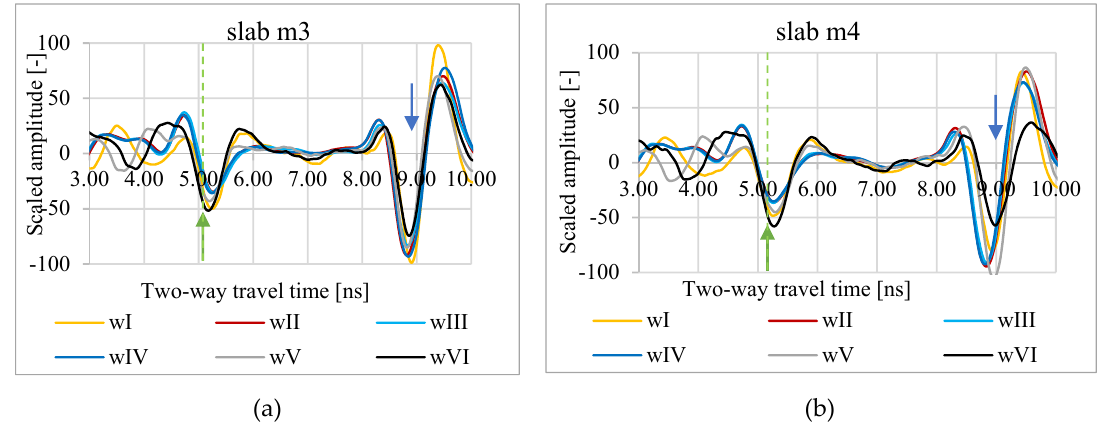
Figure 3. A-scans of m1 ( a ) and m2 ( b ) slabs in atmospheric conditions wI, wII, wIII, wIV, wV, and wVI; green arrow—assumed zero level, blue arrow—assumed bottom of the slab.